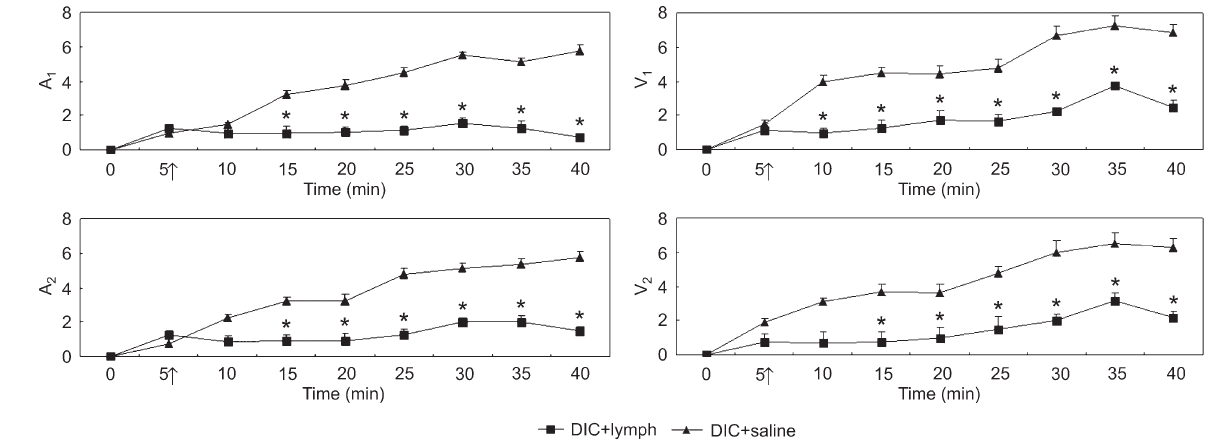
Figure 3. Effect of exogenous normal lymph on blood flow conditions in rats with disseminated intravascular coagulation (DIC). Lymph or saline was injected ( iv ) at 6 min (arrow). Data are reported as means ± SD for 10 rats. A 1 = first-order arterioles; A 2 = second- order arterioles; V 1 = first-order venules; V 2 = second-order venules. *P , 0.05 compared to the DIC + saline group (paired t -test).